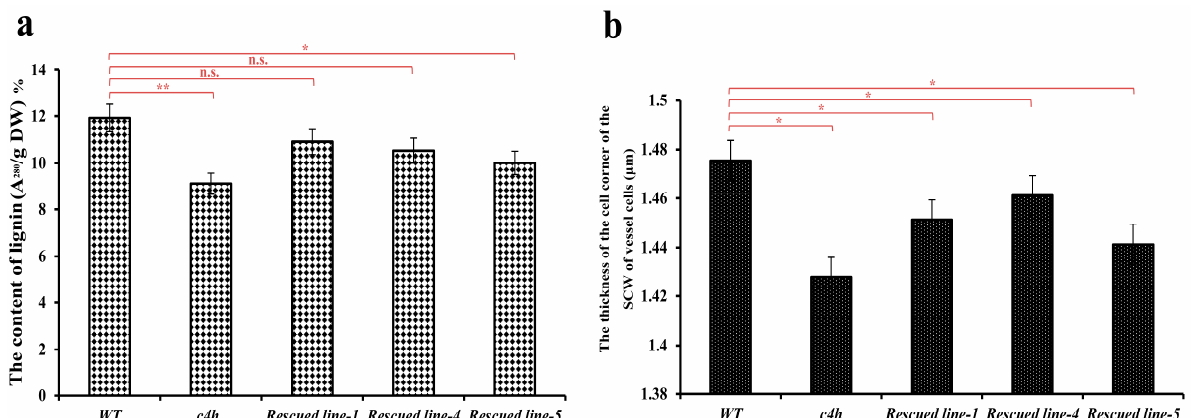
Figure 11. Statistical analysis of lignin content: ( a ) and thickness of SCW at the cell corner of vessel cells; ( b ) in WT, c4h mutants and rescued plants. WT: wild-type Arabidopsis; c4h : c4h mutants. DW: dry weight; gDW: g dry weight. Three biological replicates were performed for each sample. Student’s t test was used for the statistical analyses. ** p < 0.01; * p < 0.05; n.s. no significance.